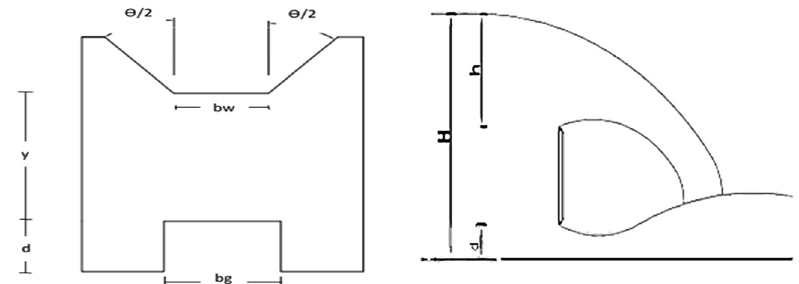
Figure 1: Investigated shapes of projectiles ( Geometry and dimensions